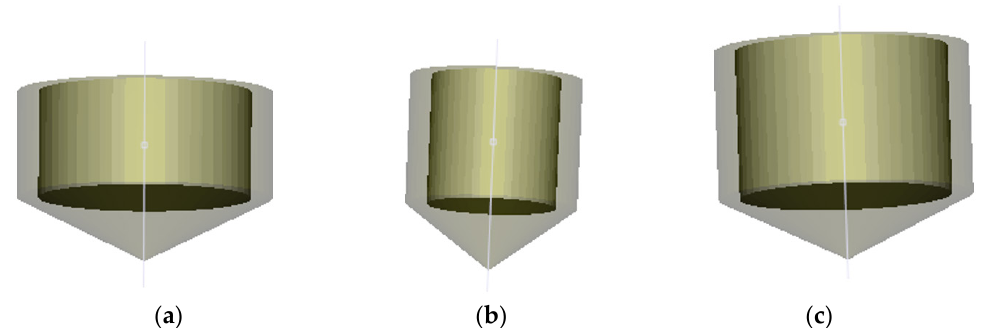
Figure 4. Implant shapes used in OnDemand3D software for bone density measurements: ( a ) 10 × Implant shapes used in OnDemand3D software for bone density measurements: 15 mm, ( b ) 5 × 6 mm and ( c ) 9 × 7 mm. ( a ) 10 × 15 mm, ( b ) 5 × 6 mm and ( c ) 9 × 7